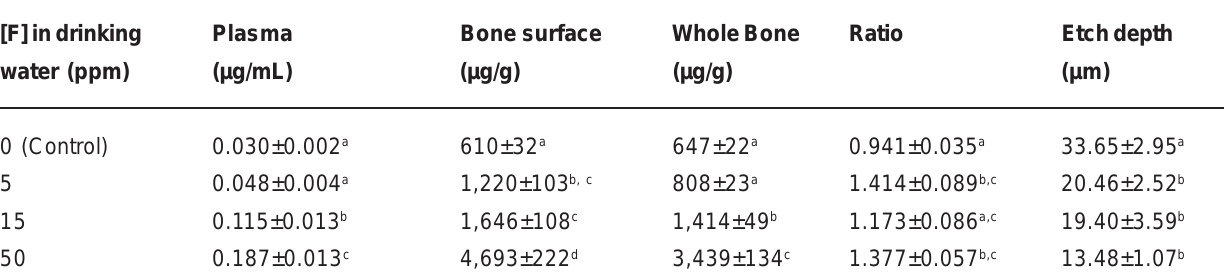
*Values in the same column with the same superscript letters are not statistically significant